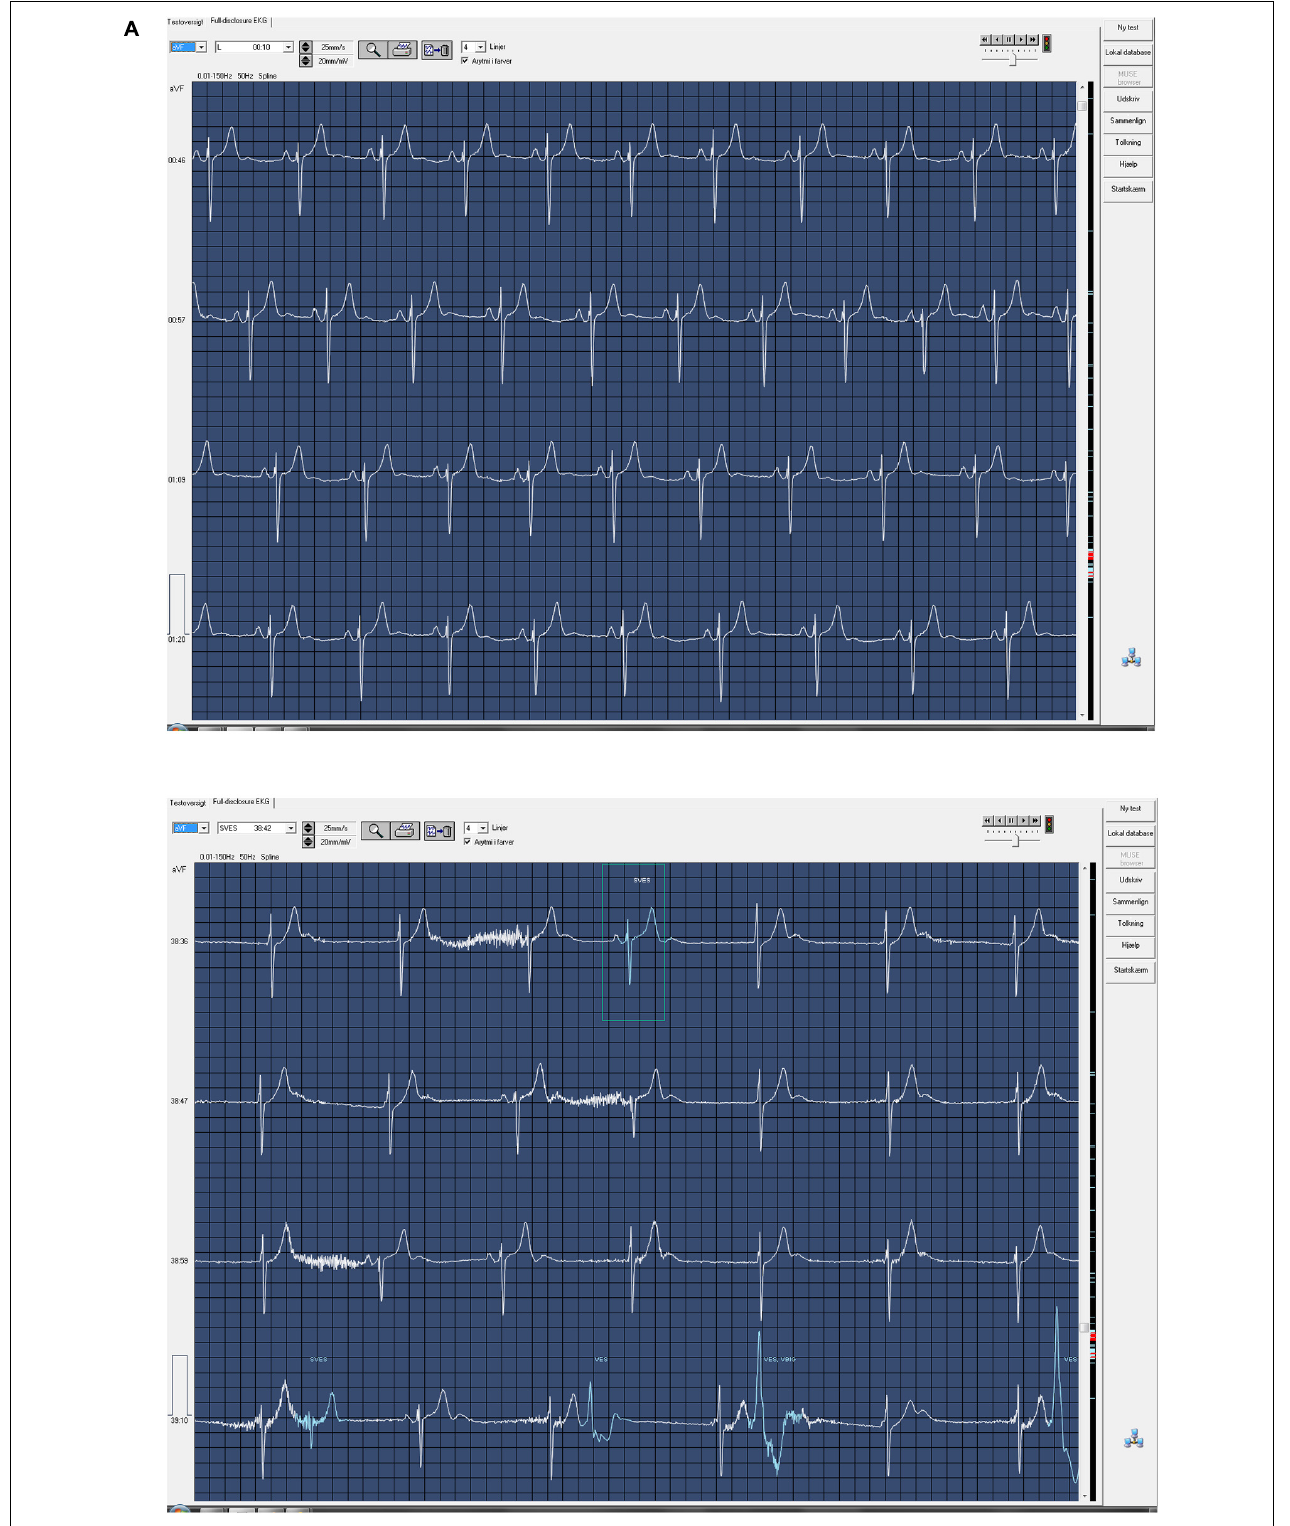
FIGURE 7 | ECG at rest and ECG during maximum dry apnea in two subjects. (A) Sinus rhythm at rest (top) and nodal rhythm during maximum dry apnea (bottom). Recorded at 25 mm/s. Continues on next page.